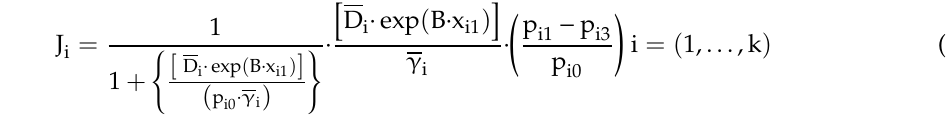
Figure 9. Flowsheet of the recirculation hybrid distillation-hydrophilic pervaporation method.